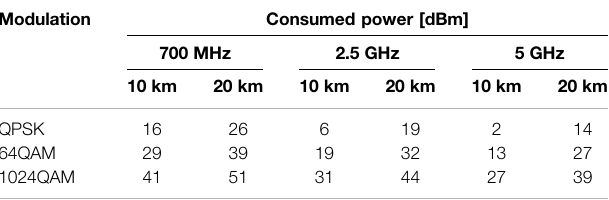
TABLE4| TotalpowerconsumptionperTRXchainforselectedmodulationsat10 and 20 km distances with 10 m antenna